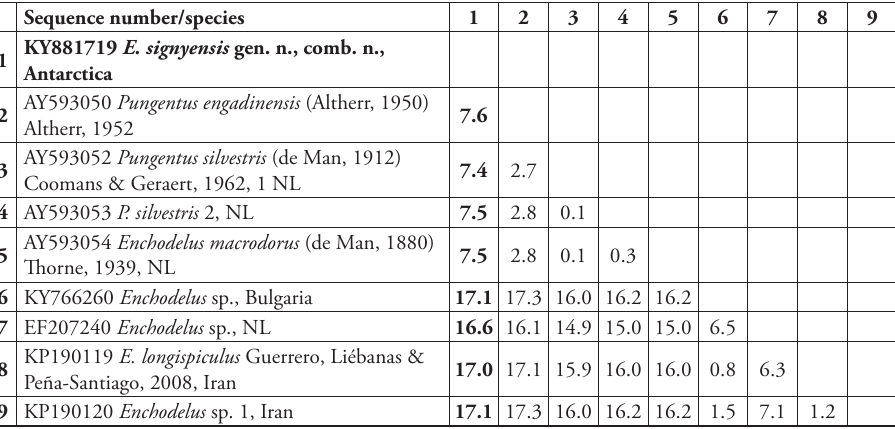
Table 5. Genetic distances using D2-D3 28S rDNA sequence data (p-distances given in percents). Pair- wise comparisons are based on alignment with 790 nucleotide positions (all positions containing gaps were